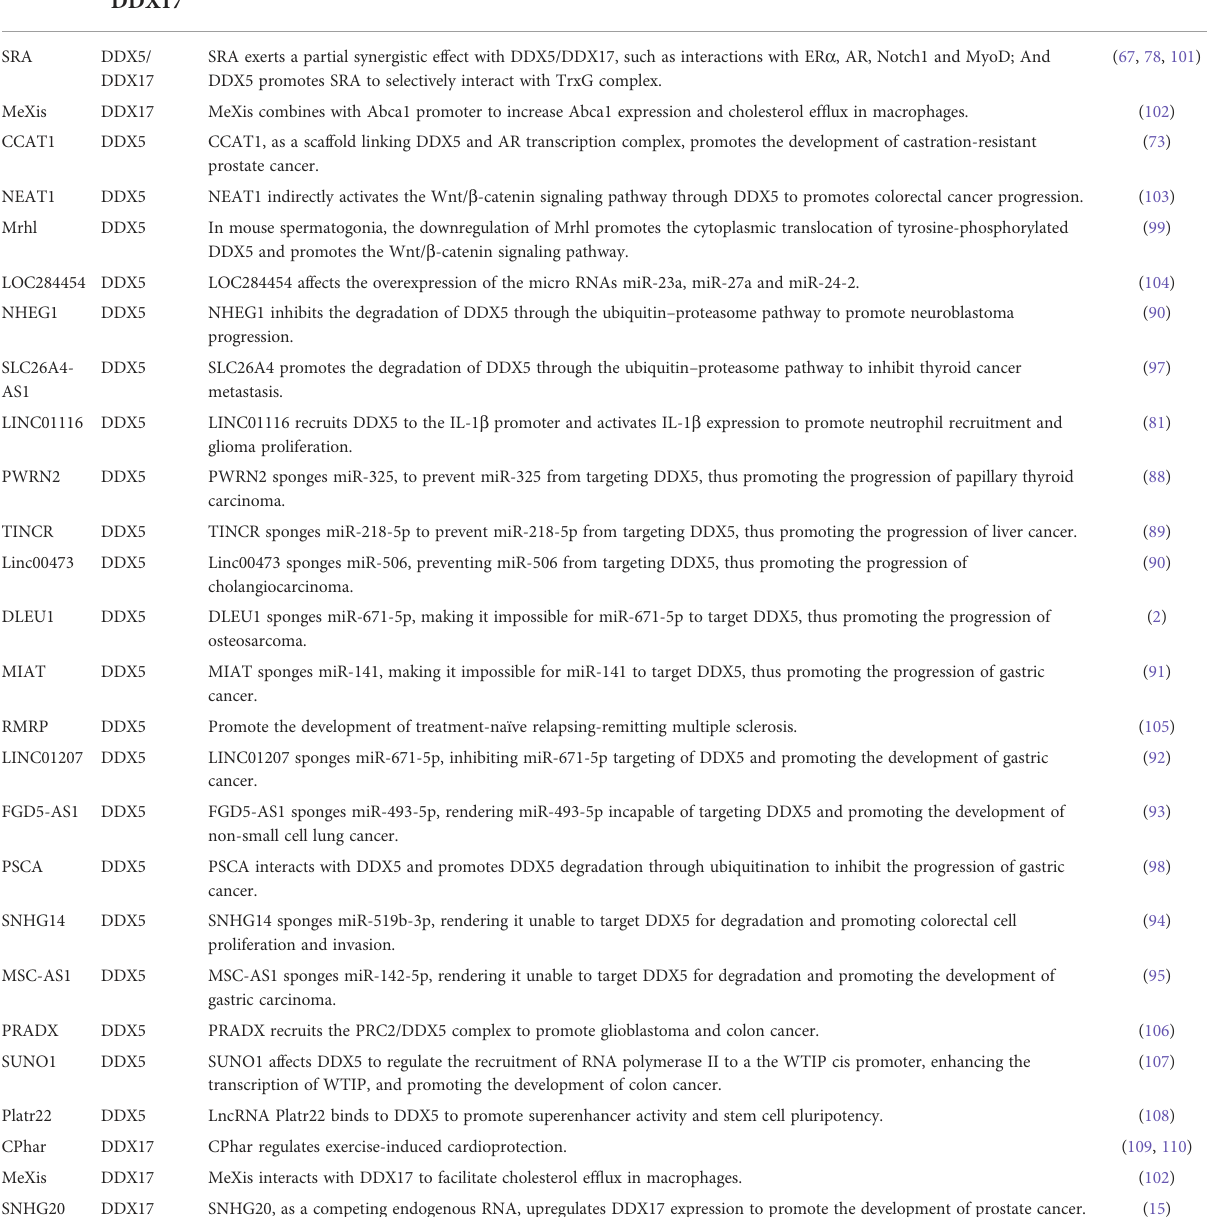
TABLE 2 Regulation of DDX5/DDX17 by